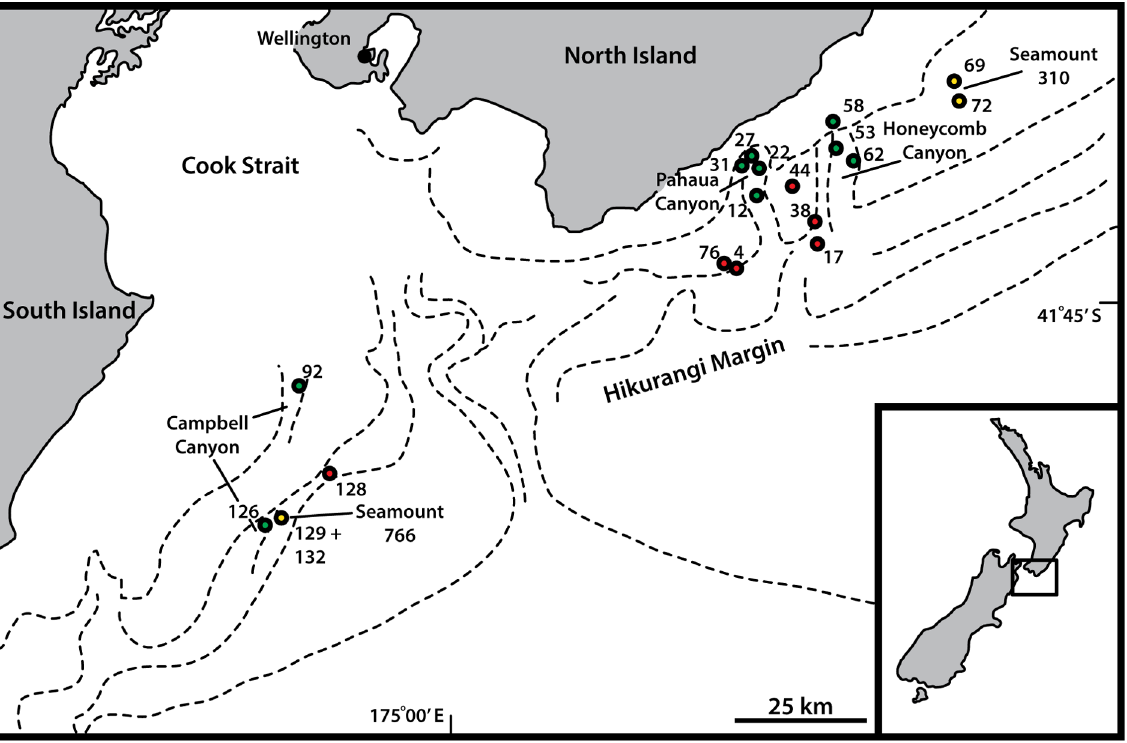
Fig. 1. Map showing the sampling stations. Colour codes indicate slopes (red), canyons (green), and seamounts (yellow). Inset shows New Zealand with a frame marking the